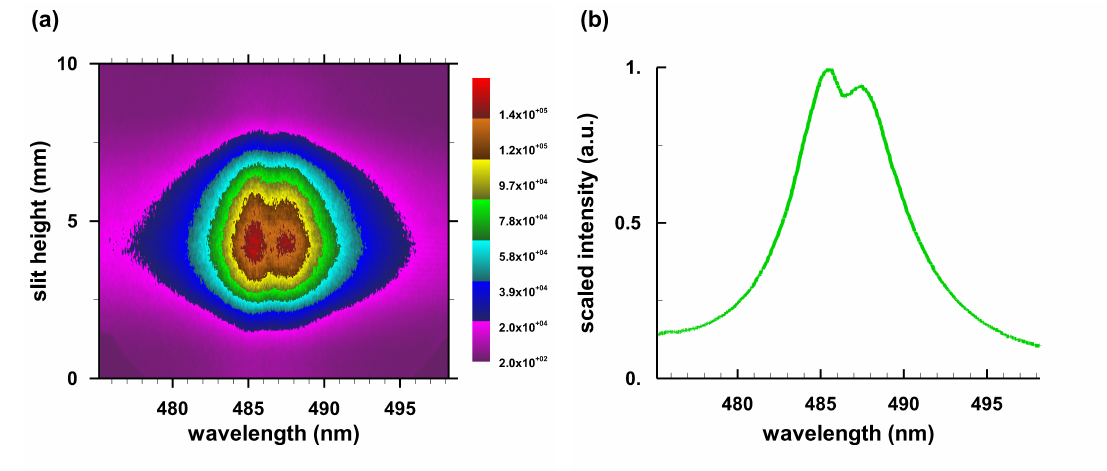
Figure A1. H β spectra for τ = 250 ns: ( a ) H β map; and ( b ) scaled average.